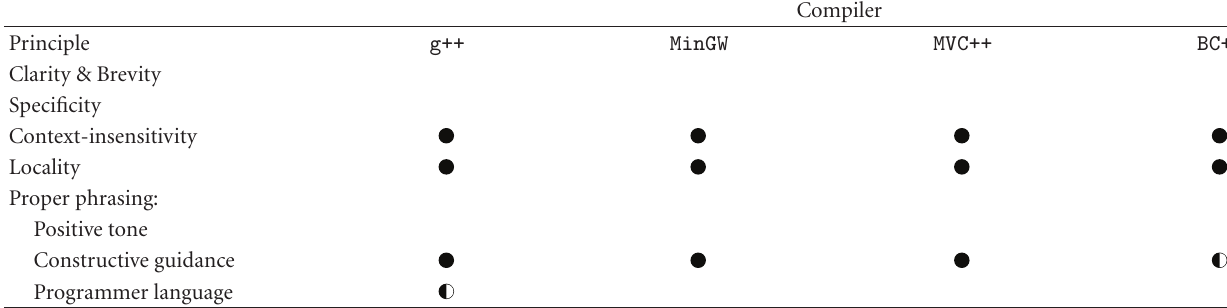
Table 7: Which principles are violated by which compilers for Error message 3.